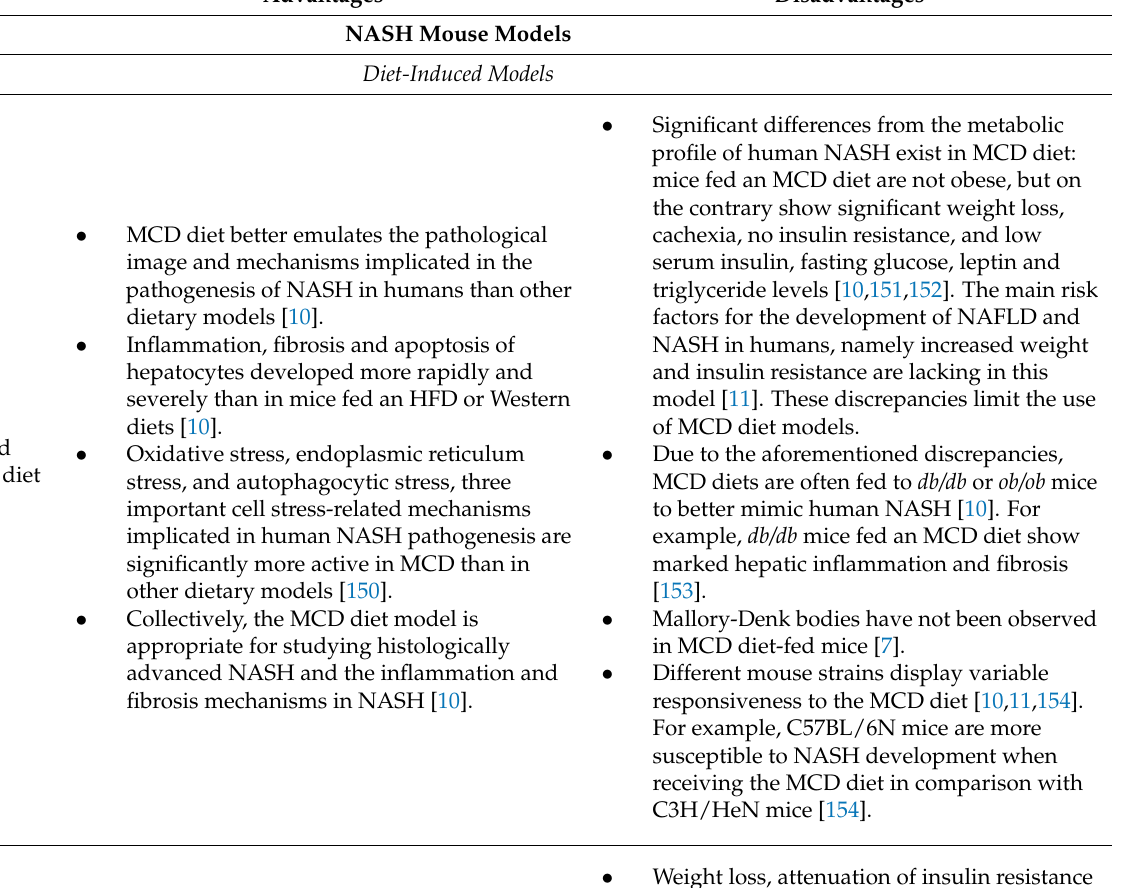
Table 1. Cont . Advantages Disadvantages NASH Mouse Models Diet-Induced